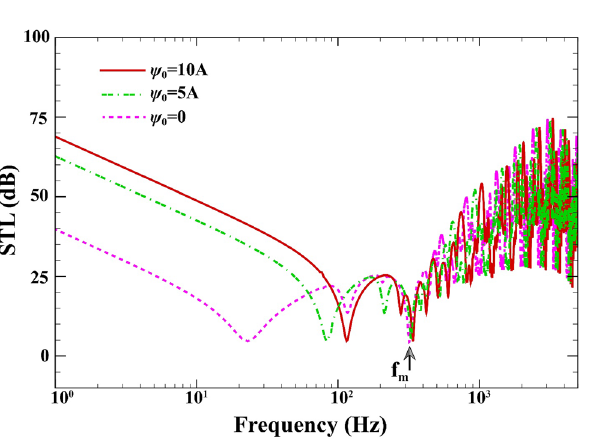
Figure 7. STL of double-walled sandwich composite MEE plate against the external magnetic